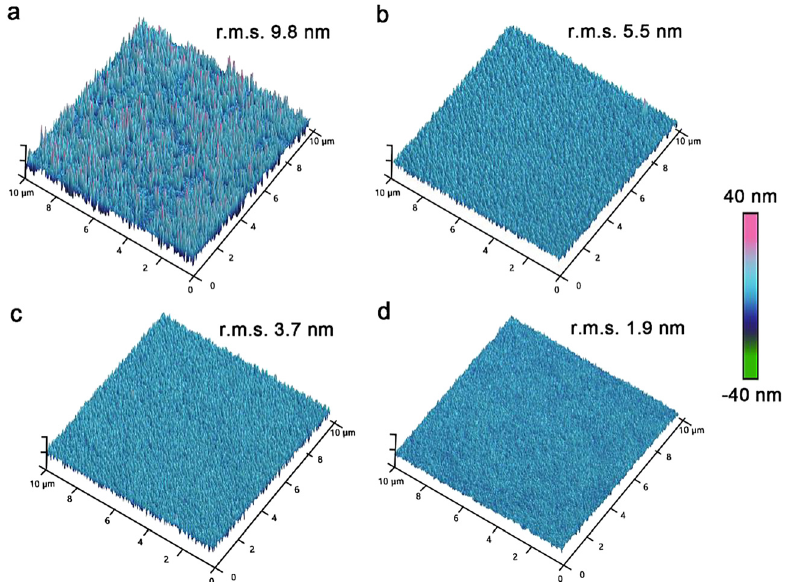
Figure 3: Morphological studiesof the CsPbBr 3 perovskite fi